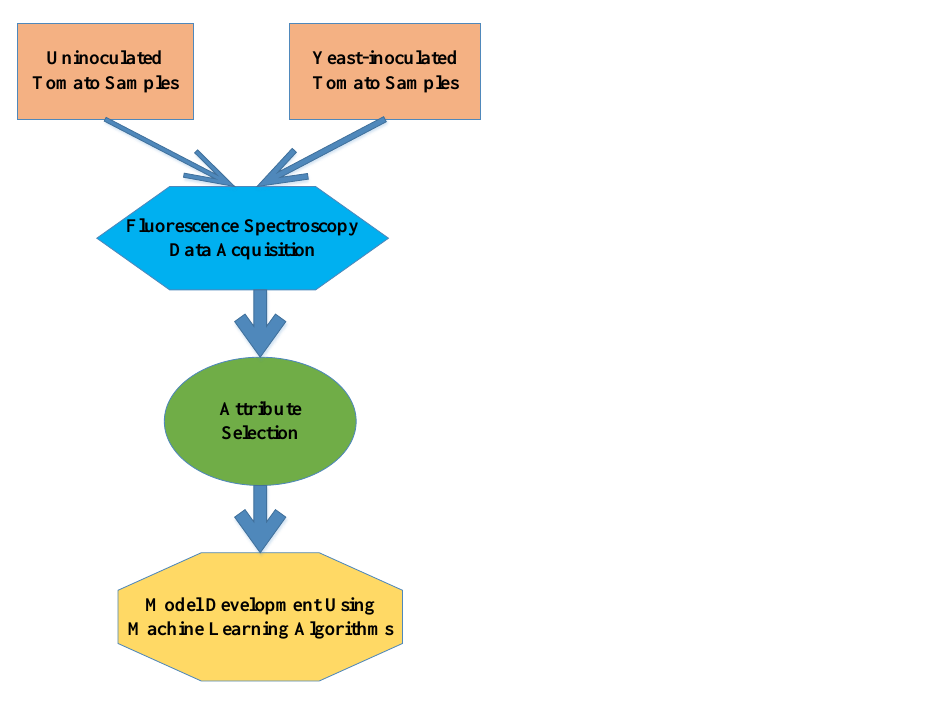
Figure 3. Schematic approach to fluorescence spectroscopic data acquisition and analysis.